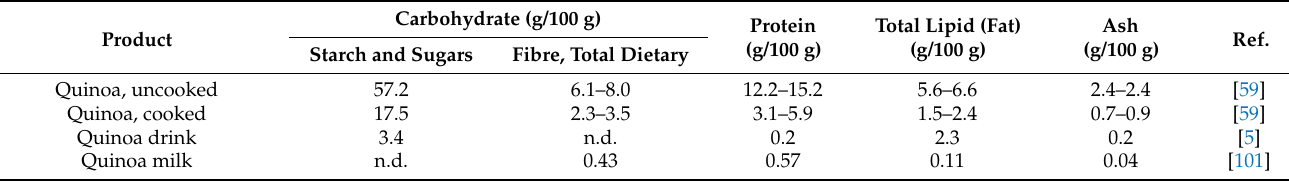
Table 7. Basic ingredients of quinoa product per 100